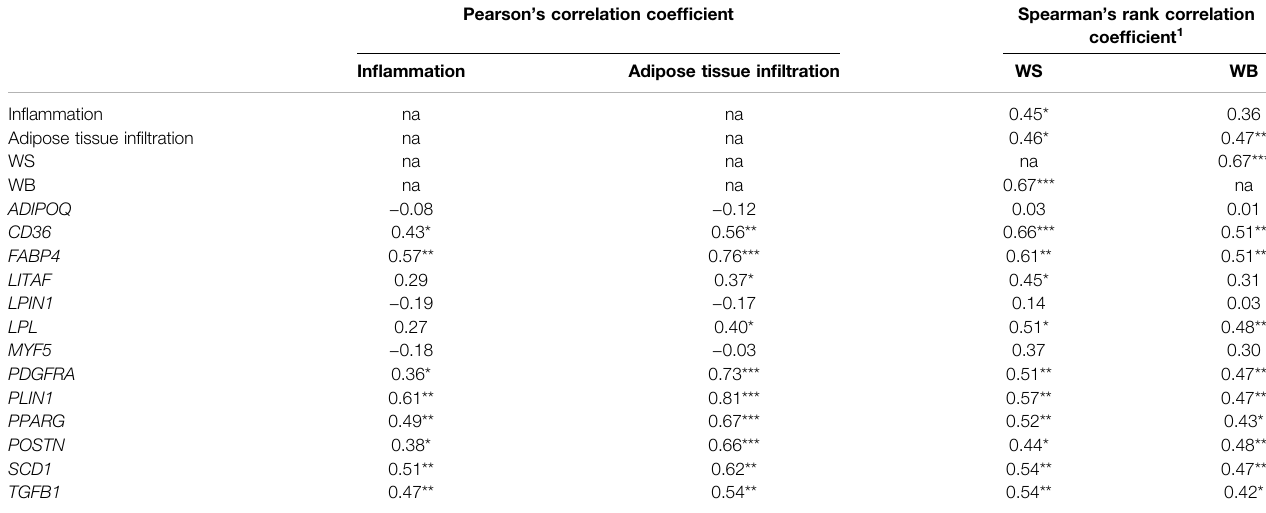
TABLE 5 | Correlation coef fi cient between histological scores, white striping (WS) and wooden breast (WB) abnormalities, and absolute transcript